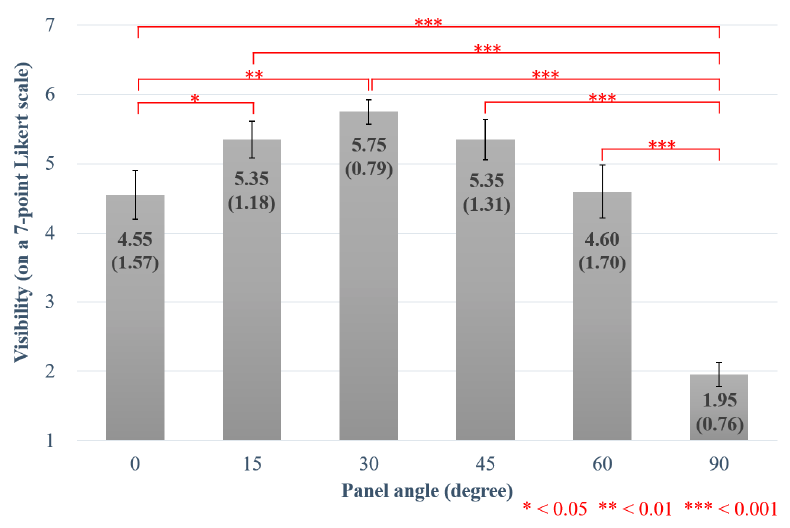
Figure 3. Visibility ratings with the results of post hoc multiple comparisons.